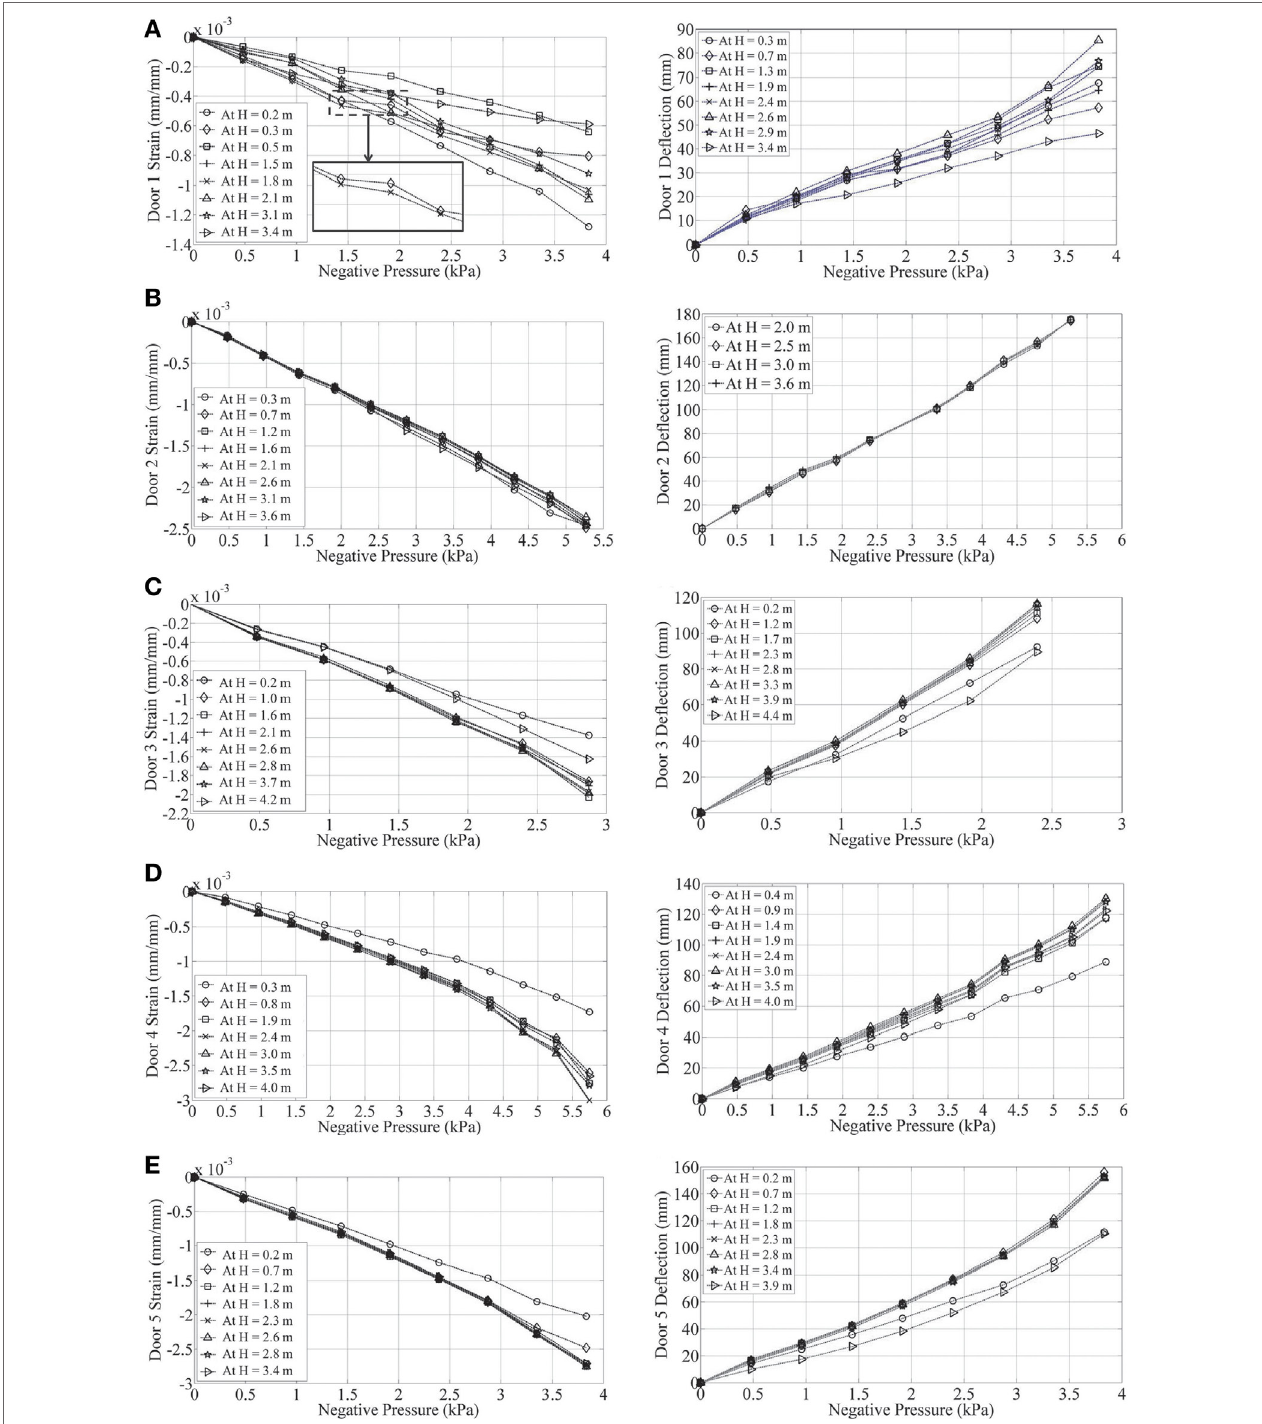
FigUre 9 | Measured pressure–strain relationships and pressure–displacement relationships for Doors 1–5 [(a–e), respectively] at multiple locations . All strains and displacements are measured at center span (see Figure 7a ) at the height indicated in the